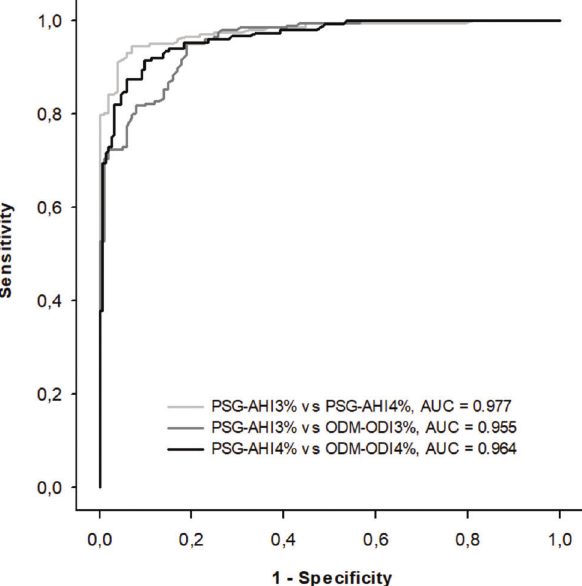
Figure 3 - Receiver-operator characteristic curves of PSG-AHI3% vs PSG-AHI4% (light gray line), PSG-AHI3% vs ODM-ODI3% (medium gray line), and PSG-AHI4% vs ODM-ODI4% (black line) PSG=polysomnography; AHI=apnea-hypopnea index; ODM= overnight digital monitoring; ODI=oxygen desaturation index;